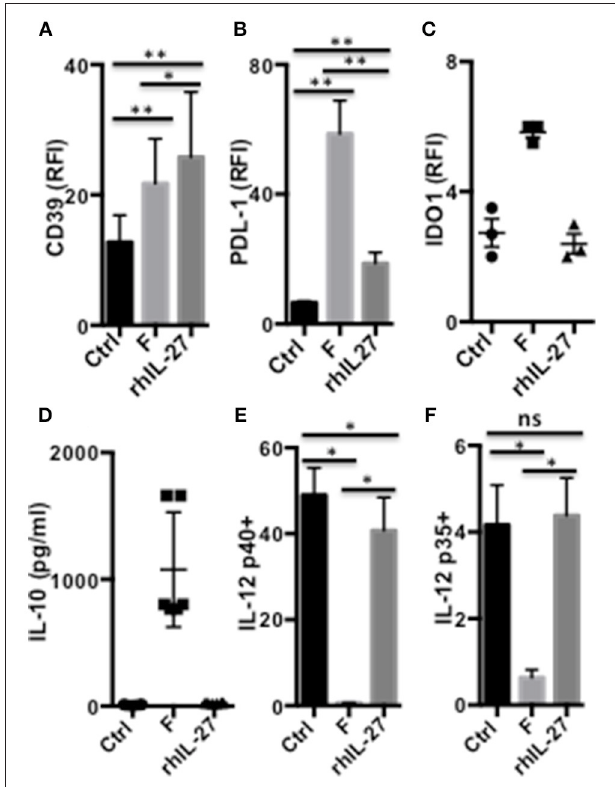
FIGURE 6 | IL-27-dependent modulation of DC functions by F. prausnitzii . Expression of CD39 [ (A) n = 8], PDL-1 [(B) n = 9] or IDO1 [ (C) n = 3], and IL-10 secretion [ (D) n = 6] by DC incubated or not for the last 24h with F. prausnitzii or with rhIL-27. IL-12p40 [ (E) n = 6] or p35 [ (F) n = 6] expression by DC incubated or not for the last 24h with F. prausnitzii or with rhIL-27 and then stimulated overnight by LPS. Wilcoxon test. * p < 0.05, ** p <